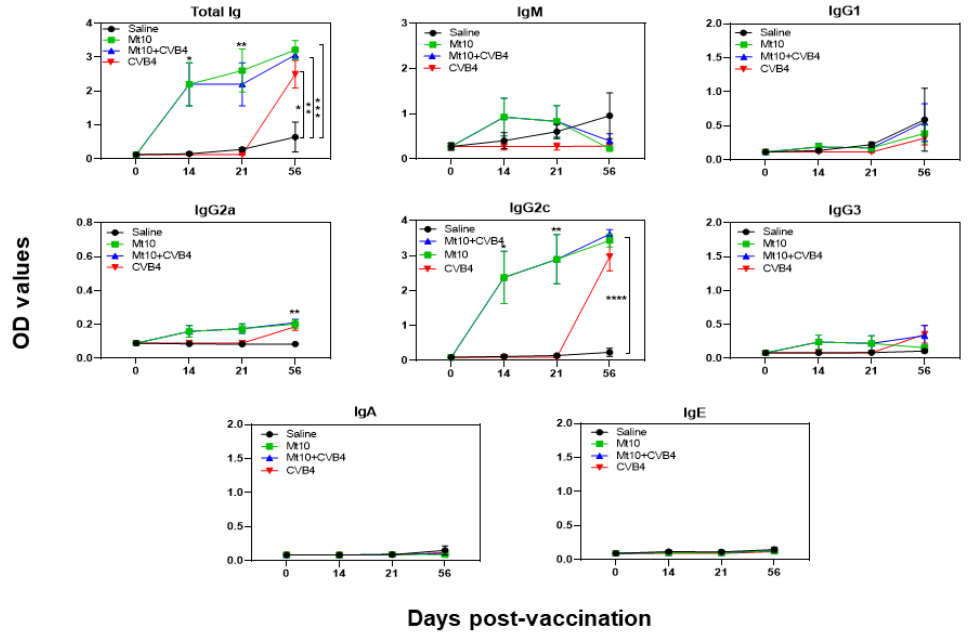
Figure 4. Antibody responses induced by Mt10 vaccine predominantly included the IgG2c subclass. Sera collected from the indicated groups at various time points were diluted (1:150) and added in duplicates to high-binding plates previously coated with CVB3-VP1 or KLH (control). After adding HRP-conjugated goat anti-mouse total Ig, IgM, IgG1, IgG2a, IgG2c, IgG3, IgA, and IgE as detection antibodies, reactions were stopped. Plates were read at 450 nm to obtain the OD values. Mean ± SEM values obtained from n = 5 – 8 samples are shown. Two-way ANOVA and Mann–Whitney U test were used to determine significance between groups. * p ≤ 0.05, ** p ≤ 0.01, *** p ≤ 0.001, and **** p ≤ 0.0001.